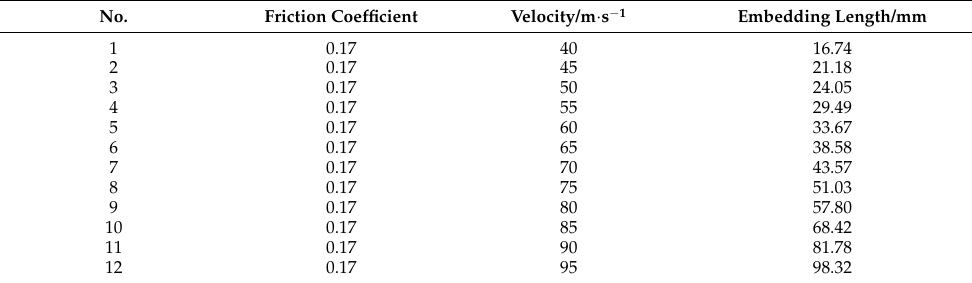
Figure 13. Velocity and embedding length curves. Table 4. Simulation tests and results in the presence of tangential contact